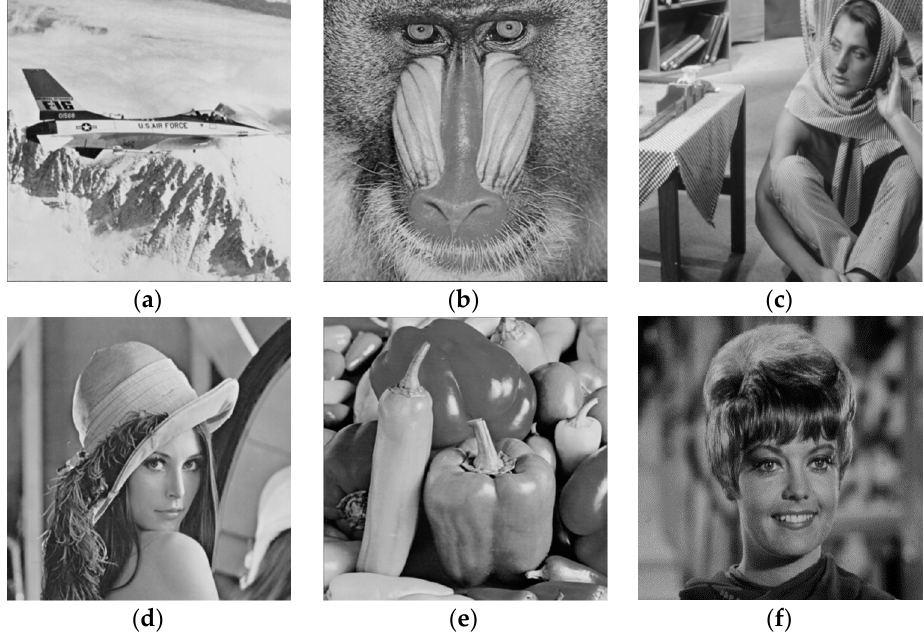
Figure 5. Six test images. ( a ) Airplane; ( b ) Baboon; ( c ) Barbara; ( d ) Lena; ( e ) Peppers; ( f ) Zelda.